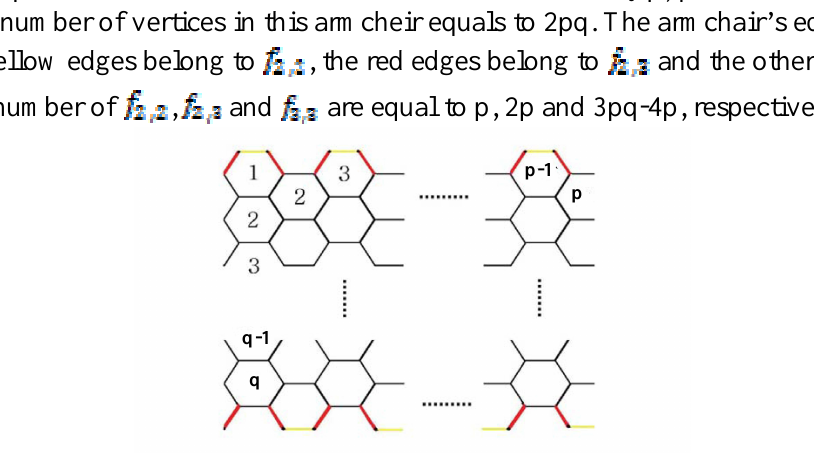
Fig. 3. The 2-Dimensional Lattice of TUAC